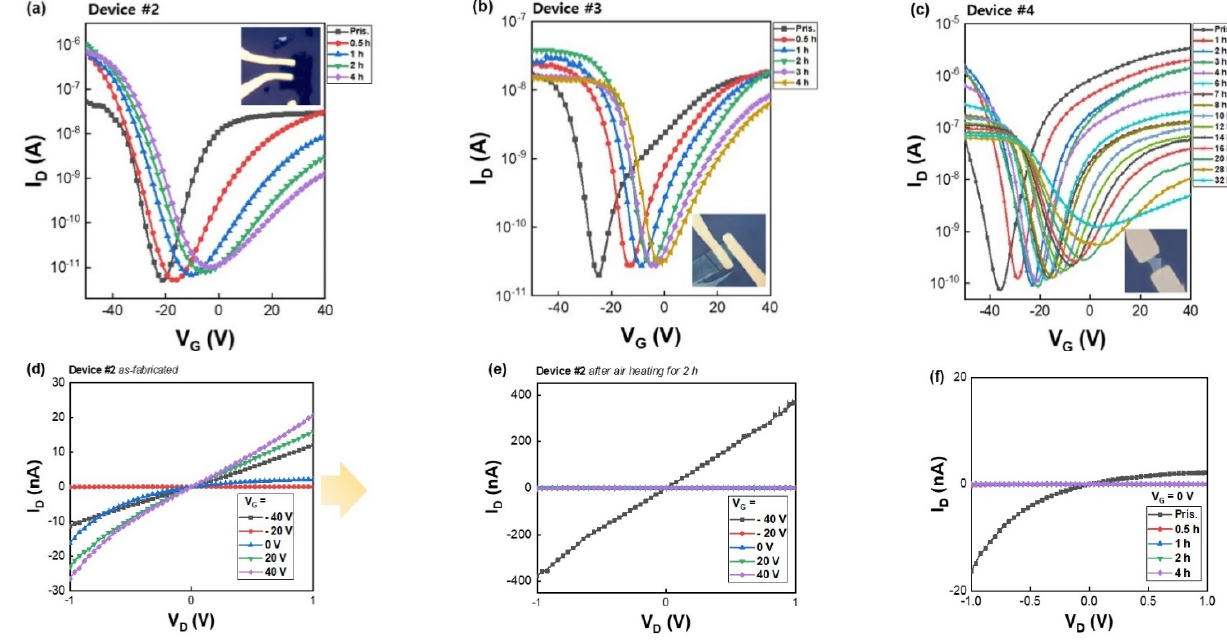
Figure 4. Transfer curves of ( a ) Device #2, ( b ) Device #3, and ( c ) Device #4 and output curves of Device #2: ( d ) as fabricated, ( e ) after air annealing for 2 h, and ( f ) at V G = 0 V.